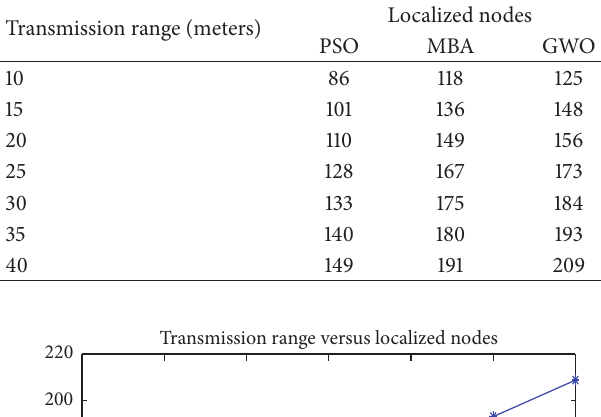
Table 3: Result by varying number of transmission range.